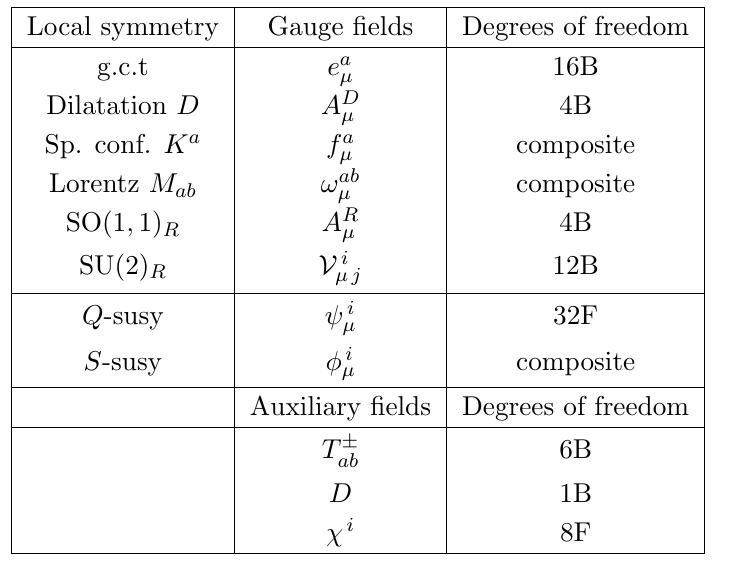
Table 2 . The 43 bosonic(B) and 40 fermionic(F) matter (cid:12)elds of the Weyl